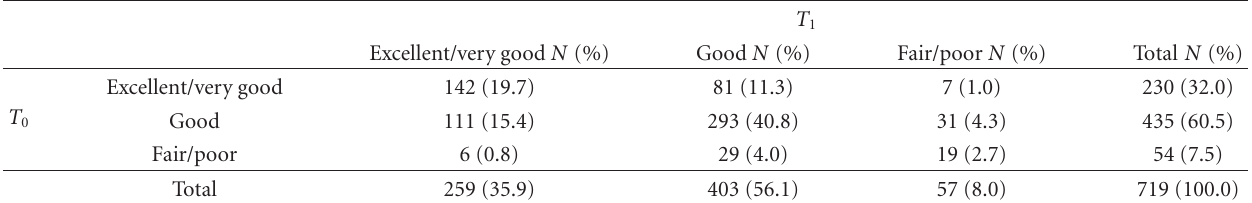
Table 2: Health in general at baseline ( T 0 ) and after one year ( T 1 ) in males.